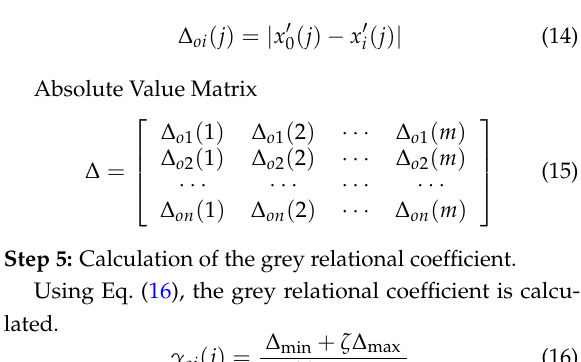
is generally considered 0.5. Step 6: Calculation of the grey relational degree. Using Eq. (17), the grey relational degree is